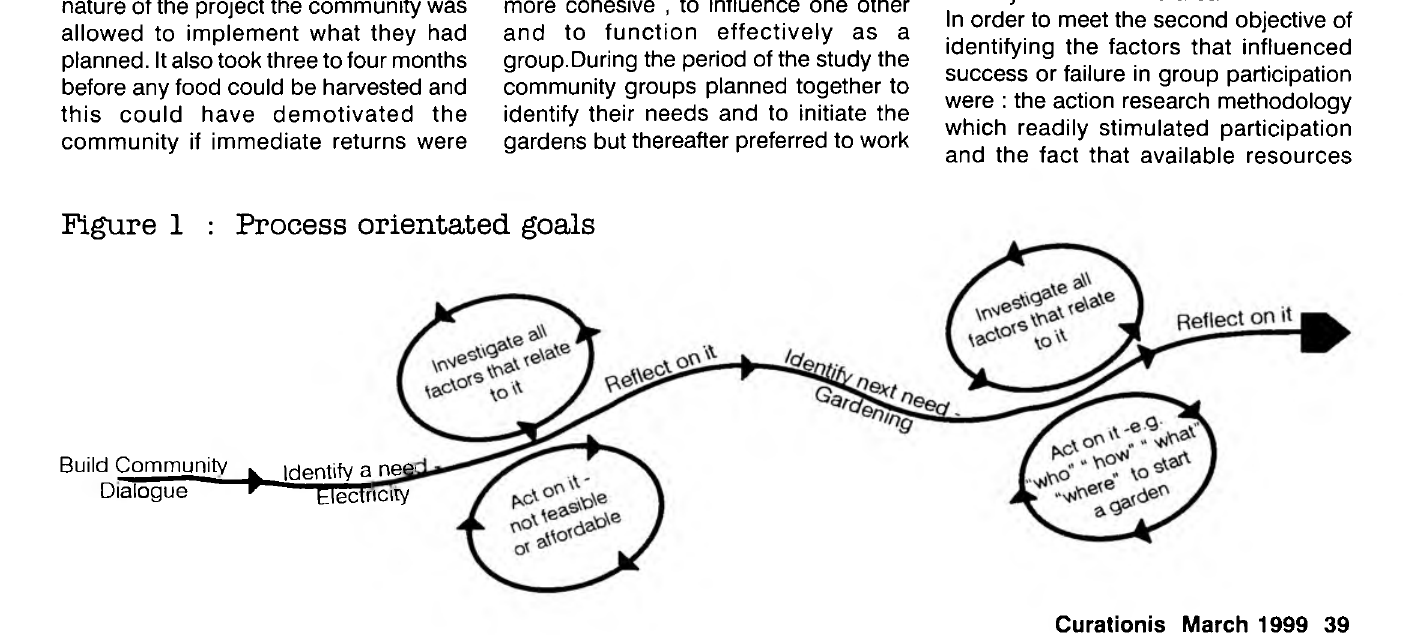
Build Community